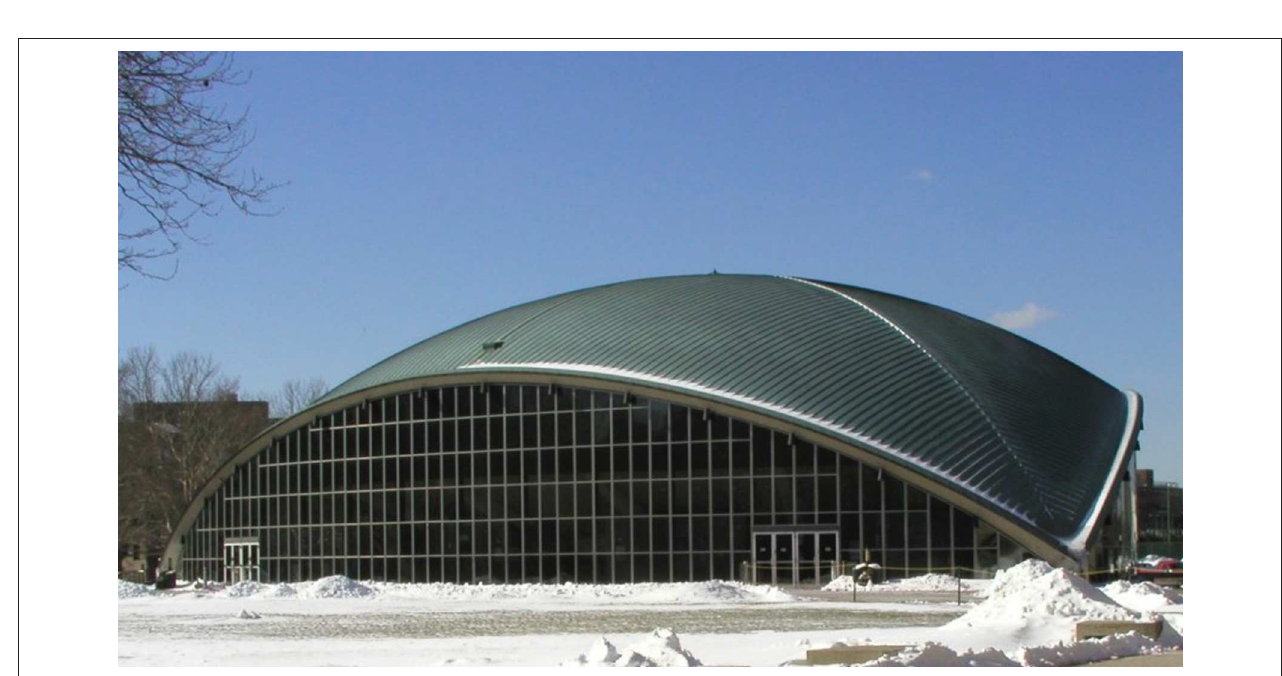
FIGURE 6 | Optimization of the pattern geometry for a hypar with the variation of reference strategy.